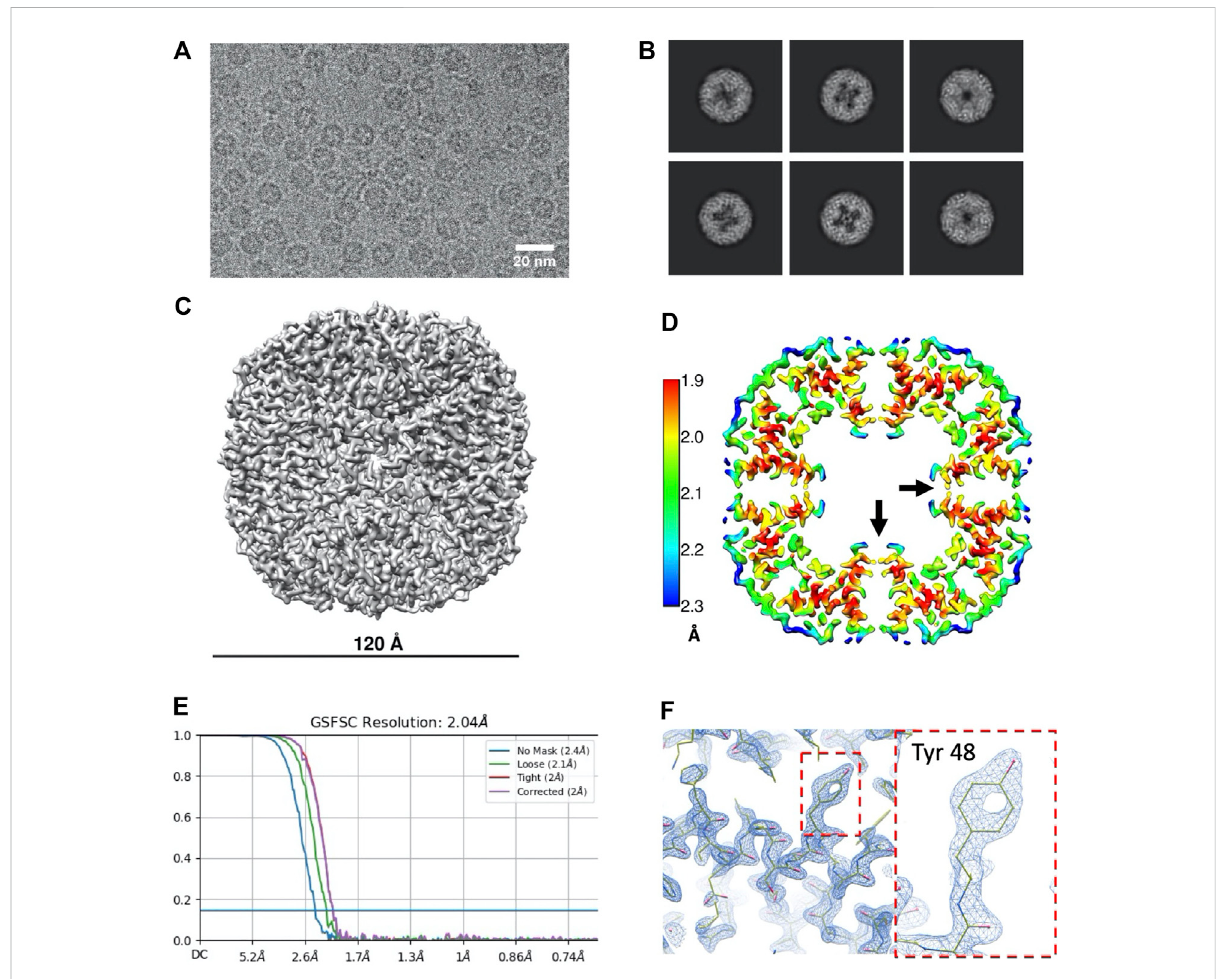
Data processing results for Flag-artemin. (A) Representative micrograph of artemin showing overall dimensions similar to apoferritin but the central cavity is partially fi lled with density (B) 2D classes showing that while the C-terminus of the monomer does point inwards from the shell, it doesnotfully fi llthecentralcavity. (C) Cryo-EMmapofFlag-artemin with~120 Åouterdiameter. (D) Thin virtual slicethrougharesolutionheat map showing the C-terminal alpha helices pointing inwards (black arrow) into the cavity. (E) Resolution estimated by gold standard at 2.04 Å at 0.143 FSC. (F) Fit of the atomic model in the sharpened map using Coot. Dashed boundary highlights are zoomed-in with the inset showing the detailed fi t for Tyr